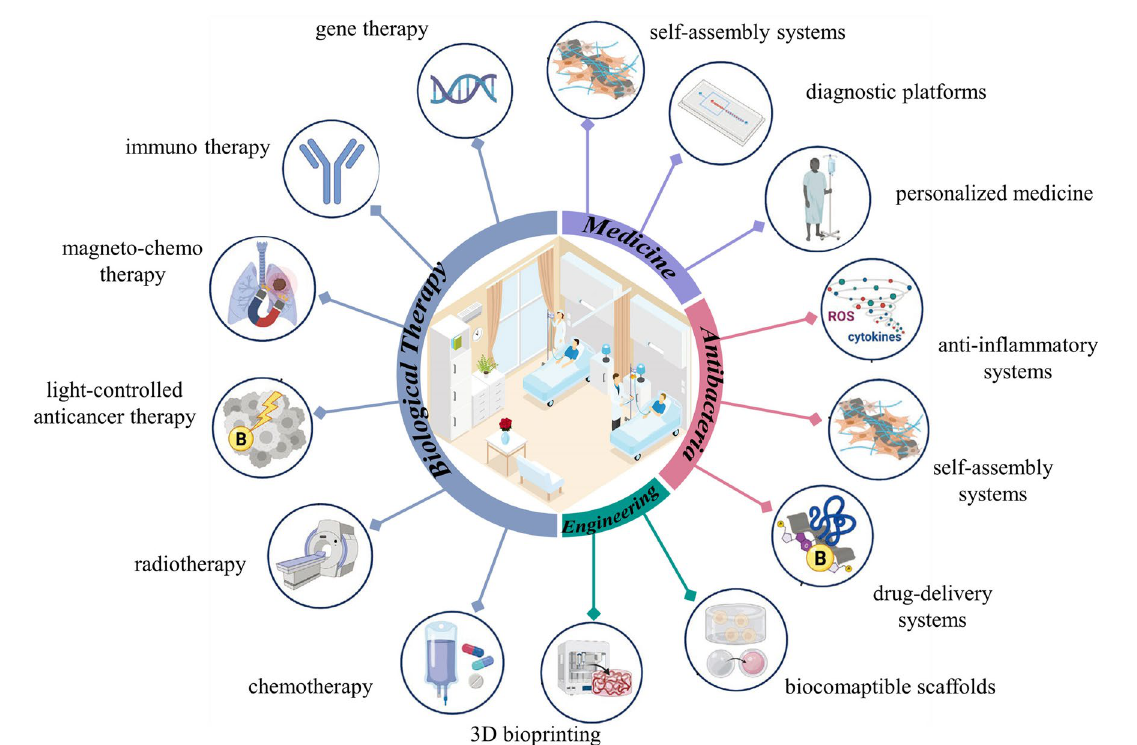
Fig. 26 Envisioned biotechnological potential of 2D MBenes. Reproduced with permission from Ref.